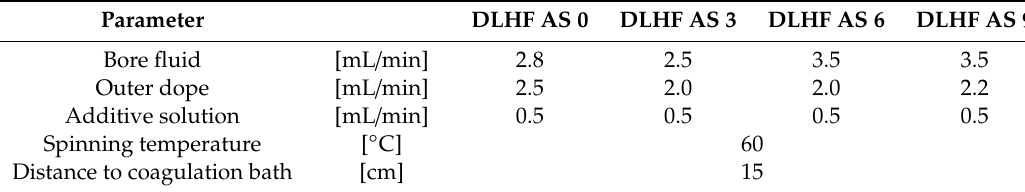
Figure 4. Scheme of the dual-layer spinneret. Inner hole: bore fluid, middle orifice: additive solution, outer orifice: dope solution. The given diameters are inner diameters. Table 2. Spinning parameters used in this